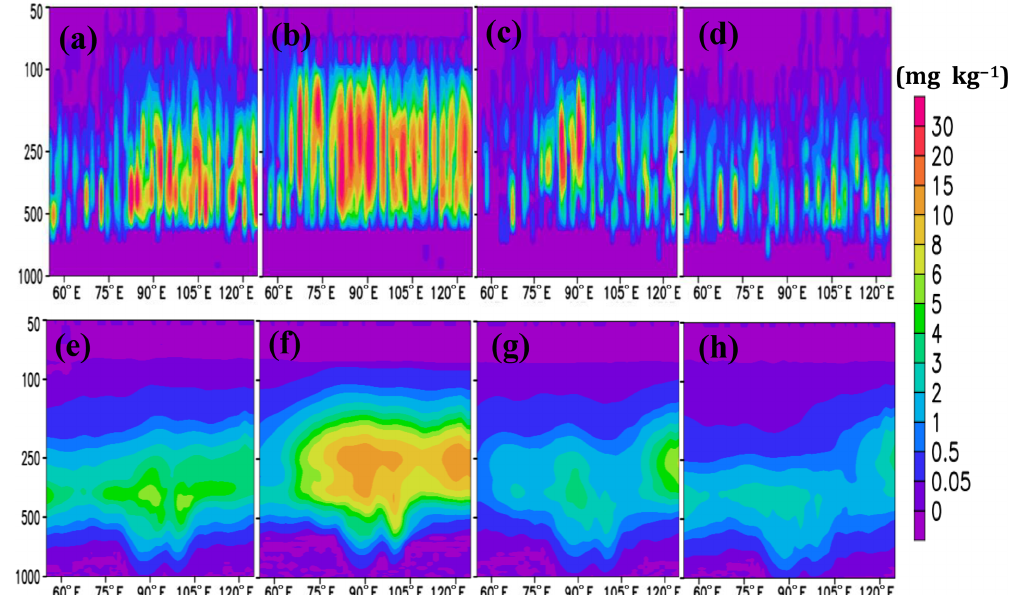
Figure 1. Seasonal mean distribution (2007–2010) of cloud ice mass mixing ratio (mgkg − 1 ) from CloudSat and CALIPSO combined 2C- ICE L3 averaged for 20–40 ◦ N for the (a) pre-monsoon, (b) summer-monsoon, (c) post-monsoon and (d) winter seasons; (e) – (h) same as (a) – (d) but from CTRL